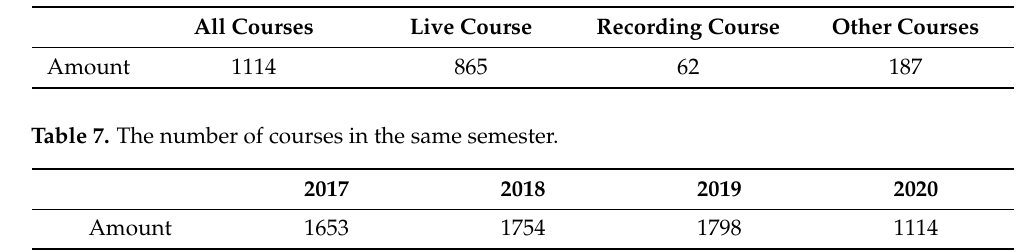
Table 6. Courses offered by teachers.